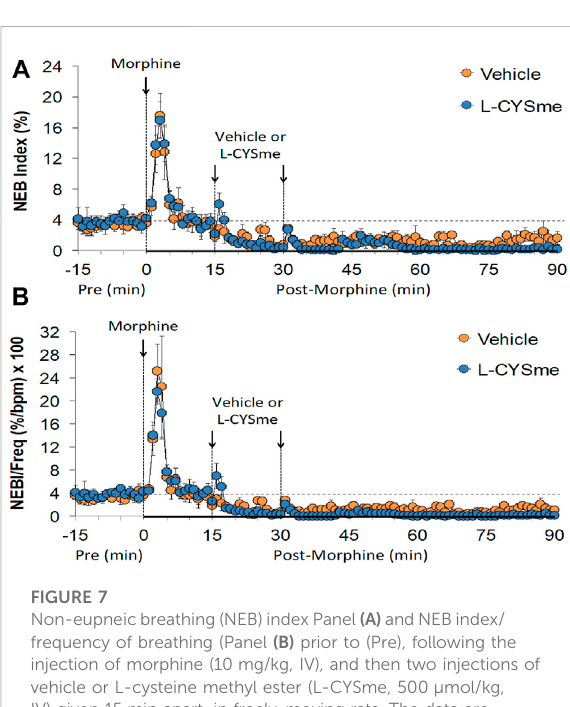
FIGURE 7 Non-eupneicbreathing(NEB)indexPanel (A) and NEB index/ frequency of breathing (Panel (B) prior to (Pre), following the injection of morphine (10 mg/kg, IV), and then two injections of vehicle or L-cysteine methyl ester (L-CYSme, 500 μ mol/kg, IV) given 15 min apart, in freely-moving rats. The data are presented as mean ± SEM. There were 6 rats in each